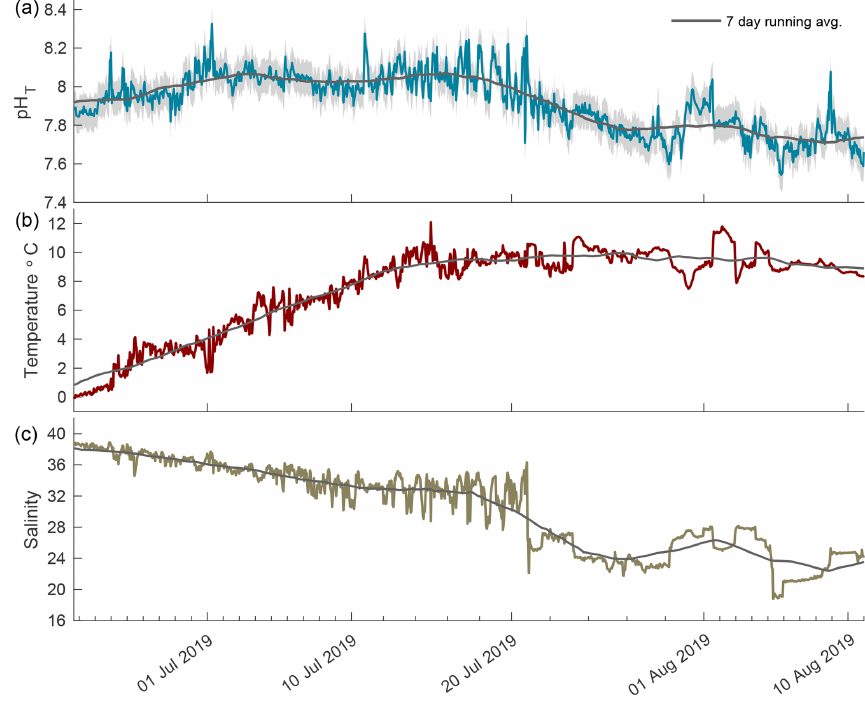
Figure 5. The 2019 open-phase time series of pH T (a) , temperature (b) , and salinity (c) in Kaktovik